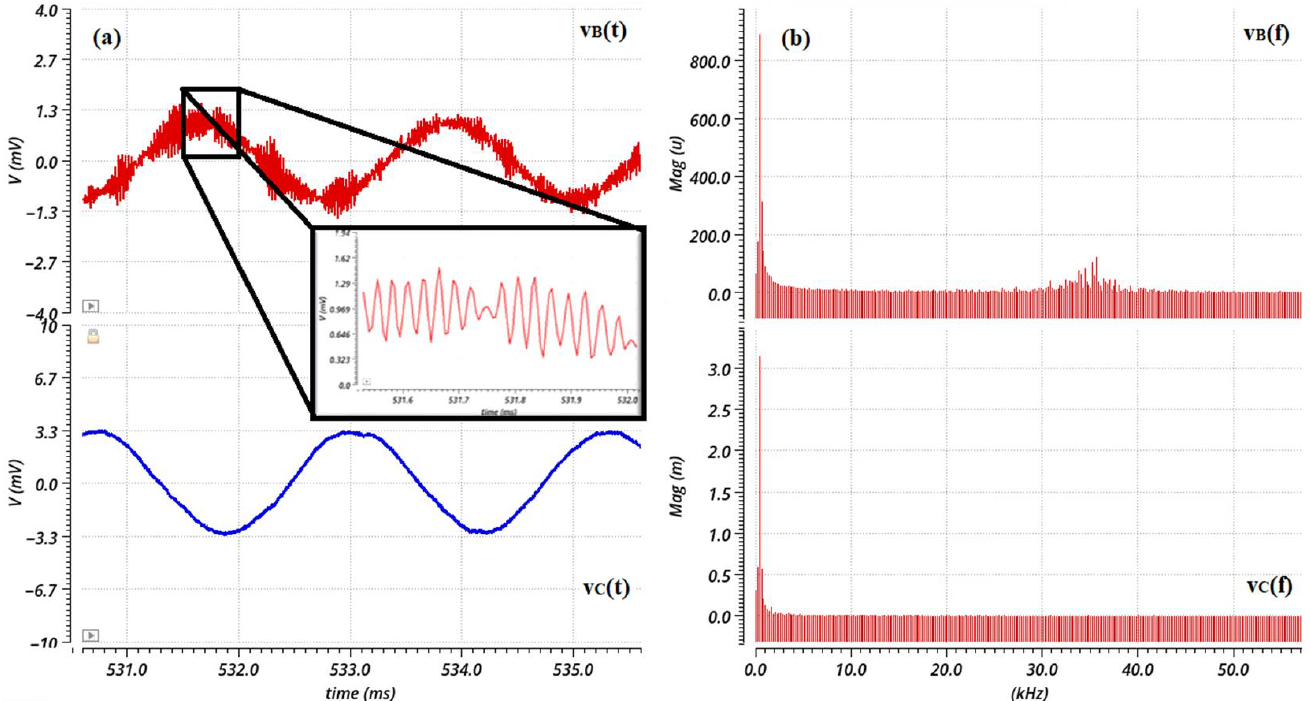
Figure 20. ( a ) Transient noise analysis and ( b ) spectrum analysis of the signal before and after filter- ing.